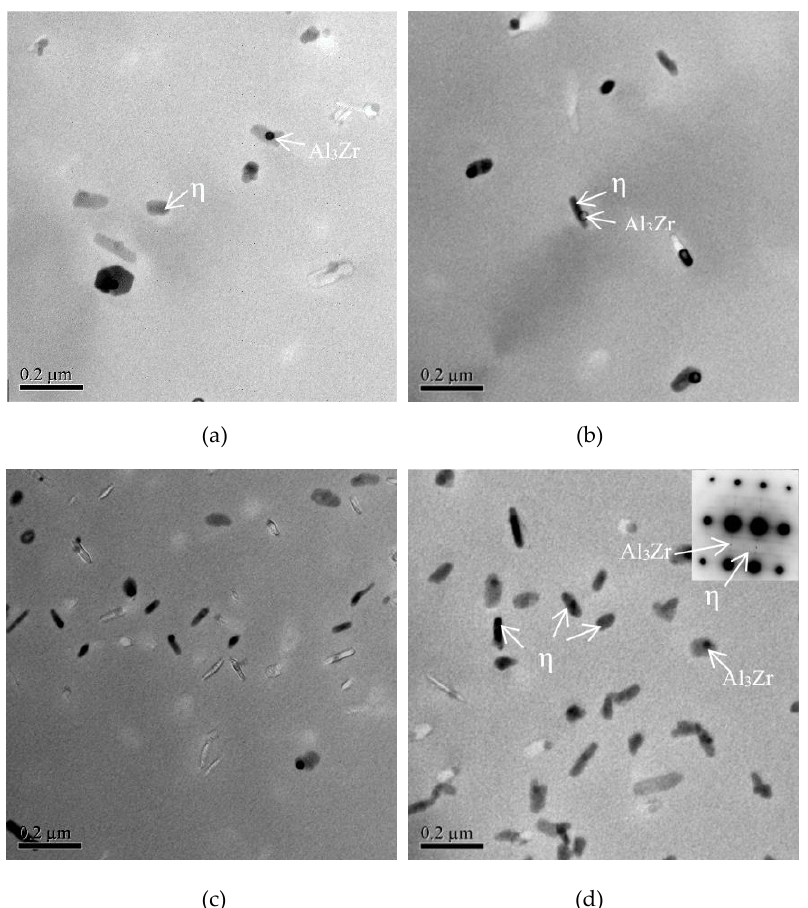
Figure 4. Transmission electron microscopy (TEM) images of 7085 aluminum alloys under ( a ) Case I, ( b ) Case II, ( c ) Case IV and ( d ) Case VI.